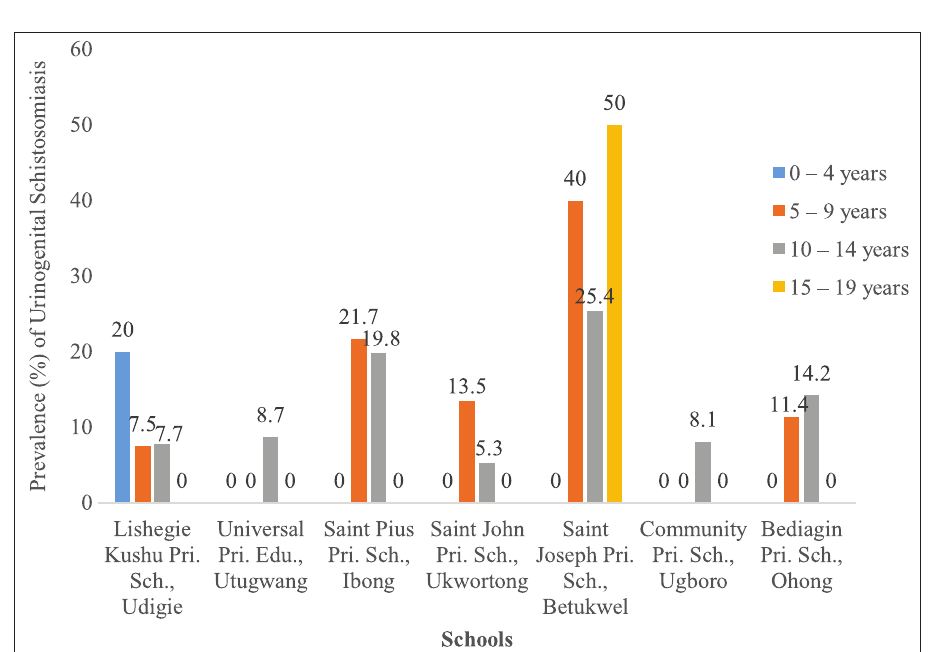
Figure 1: Prevalence of Urogenital Schistosomiasis in Relation to Age and School in the Study